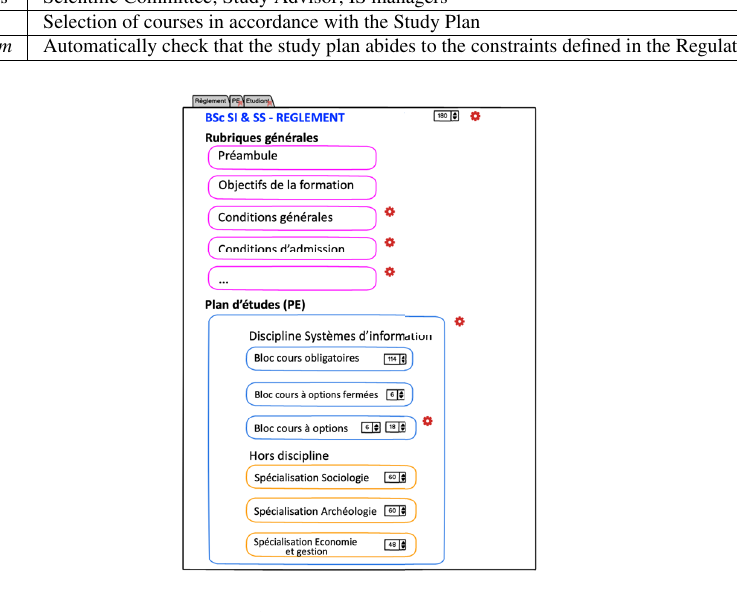
Figure 5: Mockup - Study